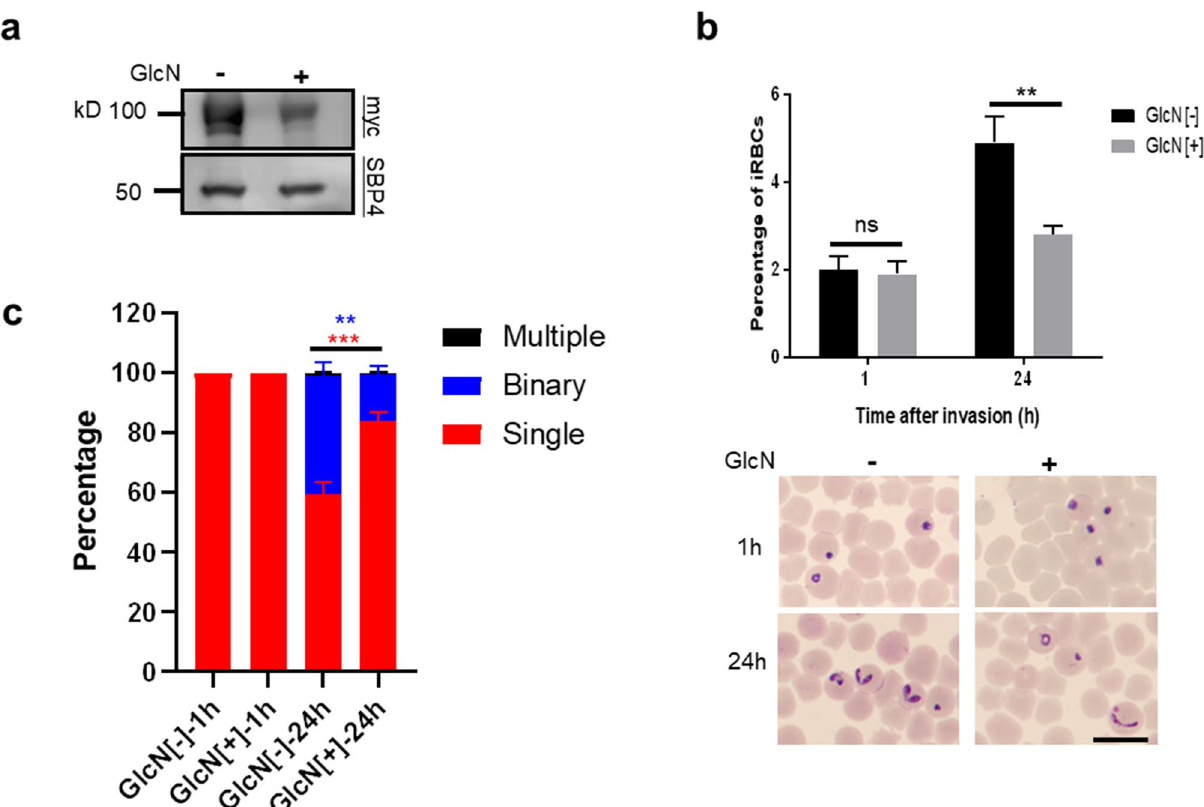
Figure 6. BbVEAP knockdown did not affect parasite invasion. ( a ) Western blot analysis of myc- glmS expressing B. bovis in the presence or absence of glucosamine (GlcN). Anti-SBP4 antibody was used to detect SBP4 protein as a loading control. The image is representative of three independent experiments. Full-length blots are presented in Sup. Fig. 3. ( b ) The myc- glmS expressing merozoites in the presence or absence of GlcN for 24 h were filter isolated and an invasion assay was performed. Percentage of iRBCs was measured at 1 h and 24 h after the invasion. The data are shown as mean ± S.D. of three independent experiments in triplicate culture. (ns, not significant; ** P < 0.01 determined by unpaired t test). Scale bar = 10 µm. ( c ) Proportion of ring, binary, and multiple stages in parasites in the absence or presence of GlcN at 1 h or 24 h following invasion (mean ± S.D. of three independent experiments in triplicate culture. ** P < 0.01; *** P < 0.001 determined by unpaired t